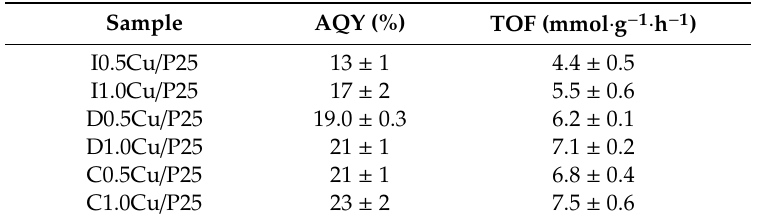
Table 2. AQY and TOF of CuO-loaded P25 photocatalysts.